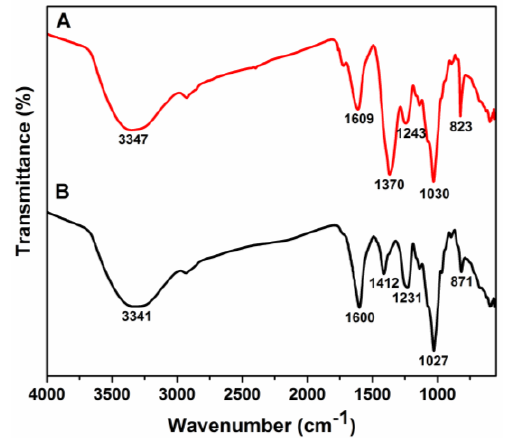
Figure 5. Fourier transform-infrared spectra of: ( A ) biosynthesized AgNPs; and ( B ) aqueous extract of Ecklonia cava .